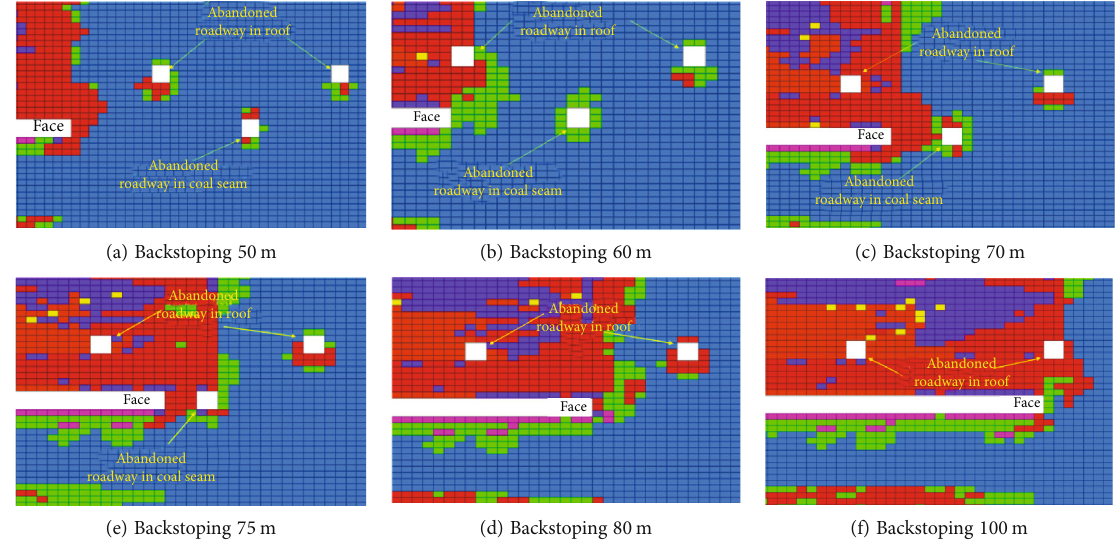
Figure 10: Development of plastic zones at di ff erent positions when the working face passes through the abandoned